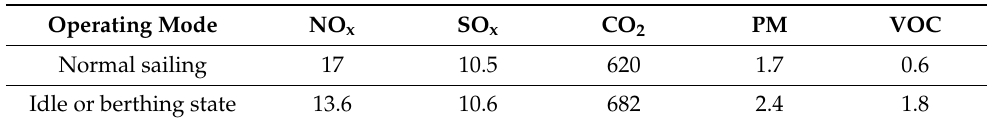
Table 1. Pollutant emissions from a typical low-speed diesel engine burning low-quality fuel [1] (unit: g/(kW ·